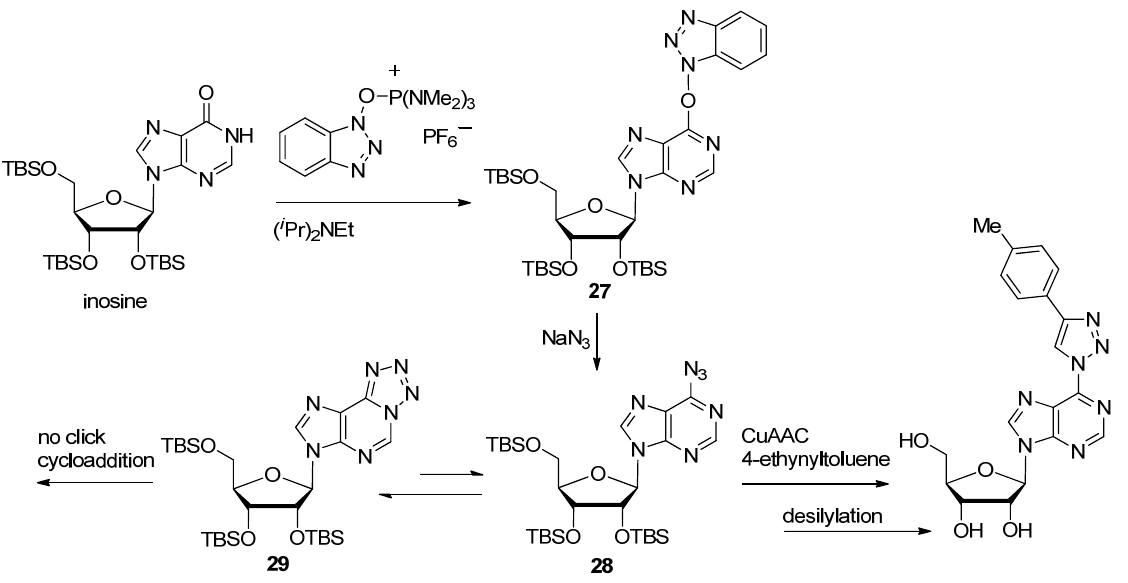
Scheme 7. Synthetic strategy to isolate the C6-azido purine tautomer for click-cyclization with various